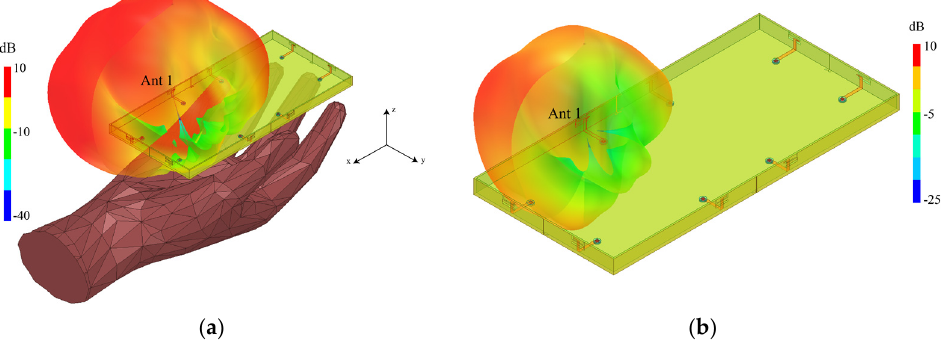
Figure 18. Simulated 3-D radiation patterns of Ant 1 of the proposed MIMO antenna system at 4.75 GHz. ( a ): Radiation pattern with a right-hand model and ( b ): radiation pattern without a right-hand model.